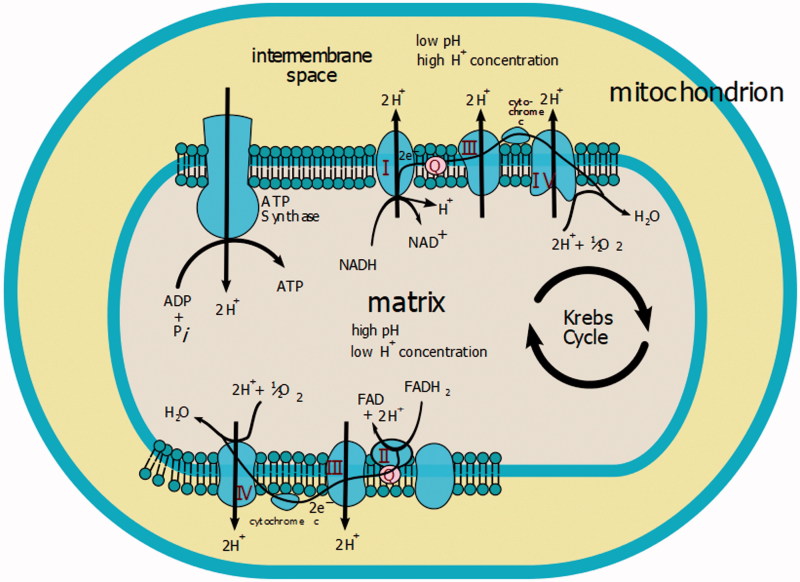
Involvement of cytochrome oxidase in the synthesis of macro-active compounds18.